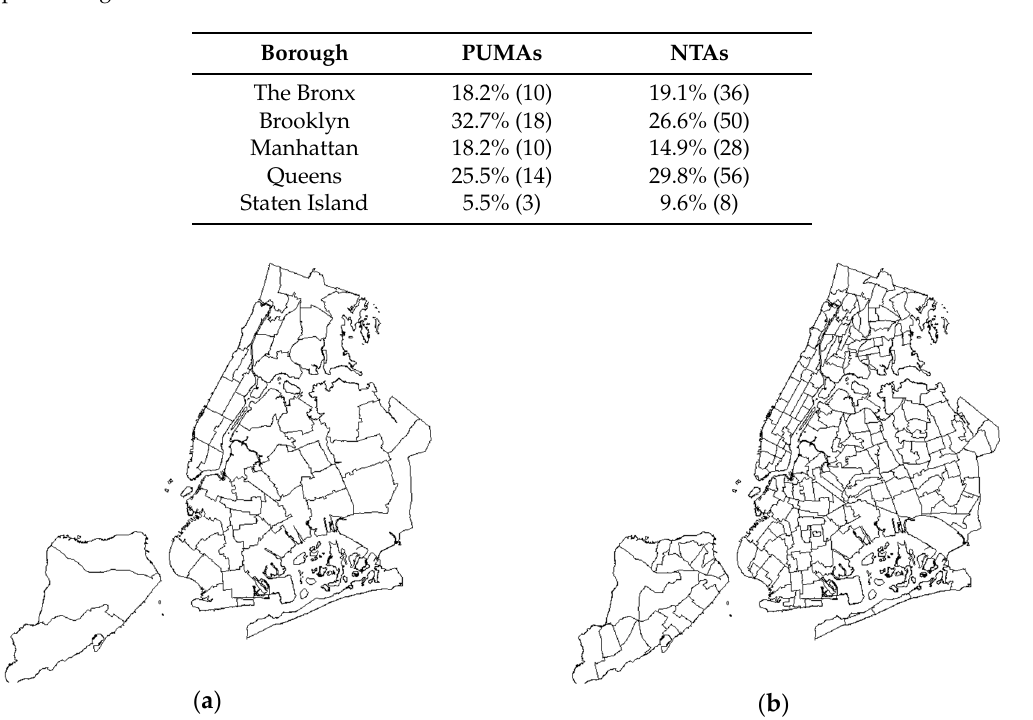
Table 1. Number of public use microdata areas (PUMAs) and neighborhood tabulation areas (NTAs) per borough.